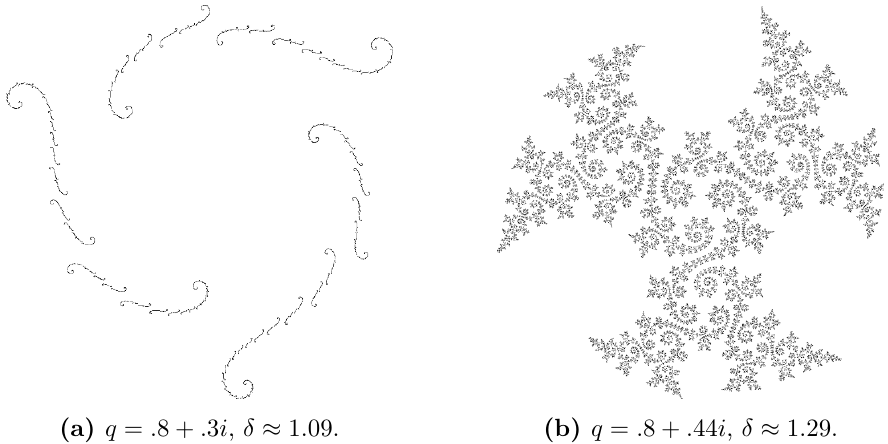
Figure 2. The limit sets for two of the Z symmetric genus two Schottky groups that arise when 3 investigating n = 3 R(cid:19)enyi entropies. The parameter q de(cid:12)ning the groups is an eigenvalue of one of the generators as speci(cid:12)ed in section 2.3. We give the value of the Hausdor(cid:11) dimension (cid:14) for these two limit sets, computed using the methods of section